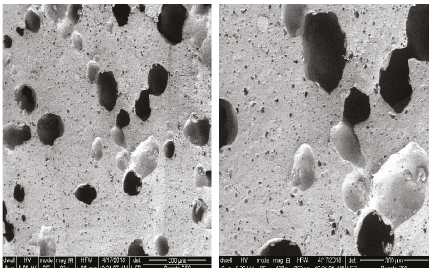
Figure 2: Images of CPUF captured by